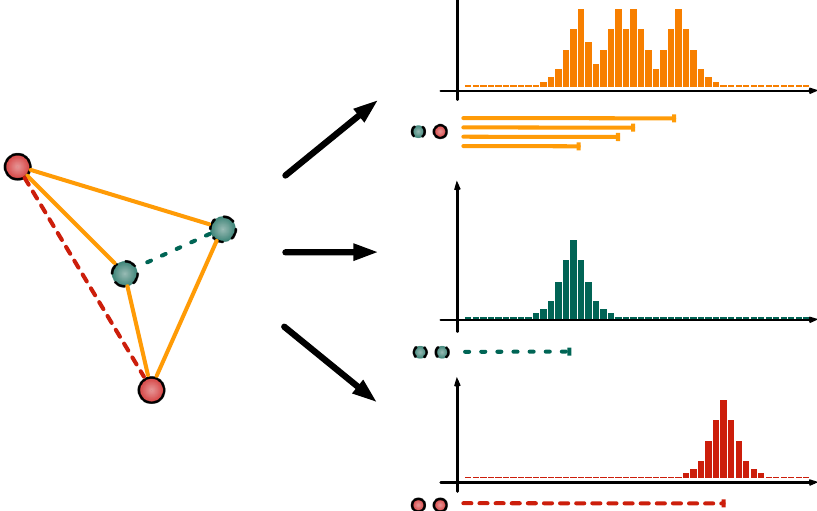
Fig. 2 Symmetry functions. Shown are radial functions G 2 described by summing contributions from neighboring atoms separately by